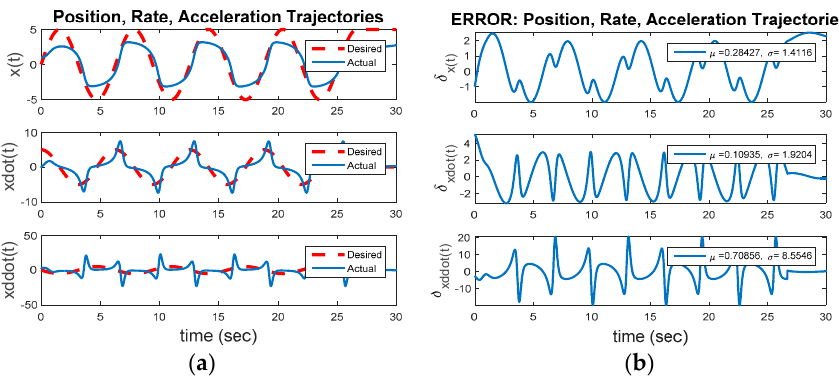
Figure 6. Trajectory comparison and errors associate with Figure 5: ( a ) displays trajectory comparison; and ( b ) trajectory.